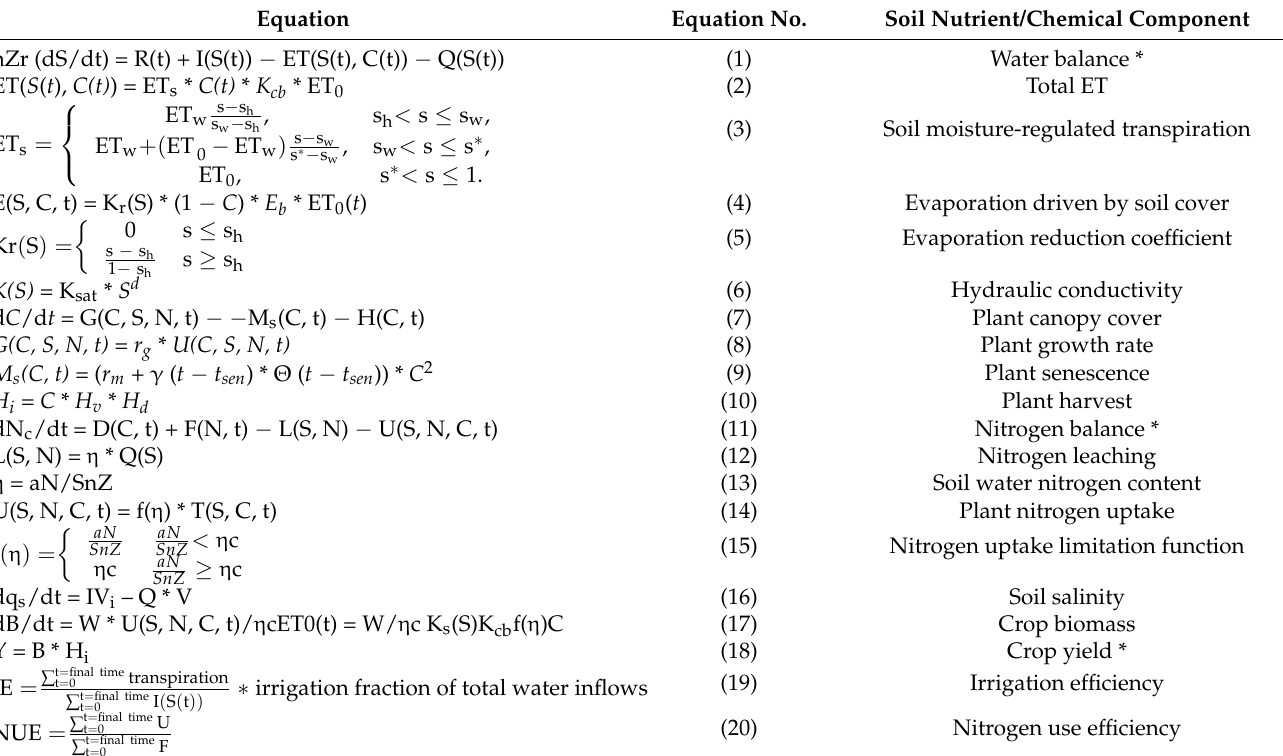
Table 1. Summary list of model physical/chemical equations constituting the core structure of the agroecosystem model, developed from [37–40]. * Descriptions indicate operationalized feedback linkage with other model components. Equation Equation No. Soil Nutrient/Chemical Component Water balance